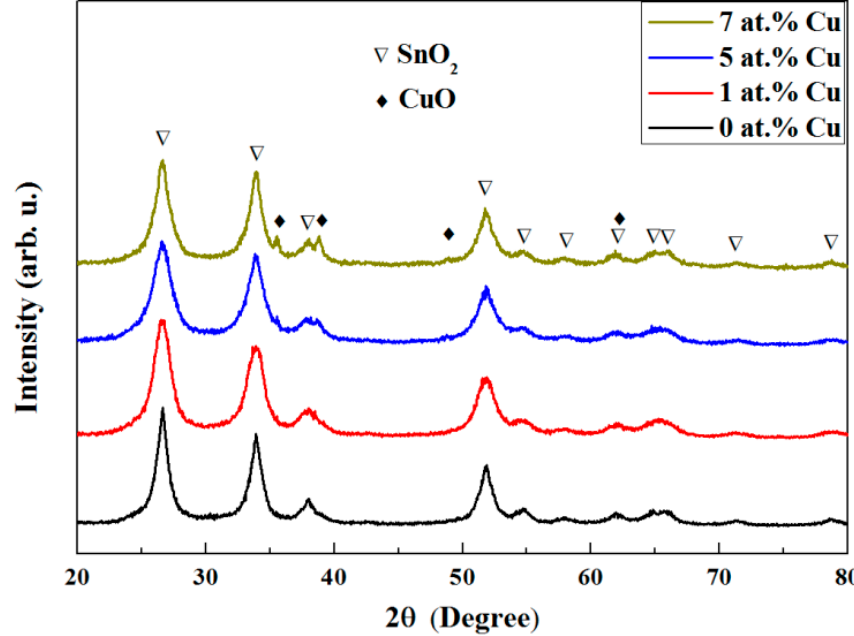
Figure 2. θ /2 θ XRD patterns of the mesoporous SnO 2 powders doped with 0 (undoped), 1, 5 and 7 at.% at.% Cu.